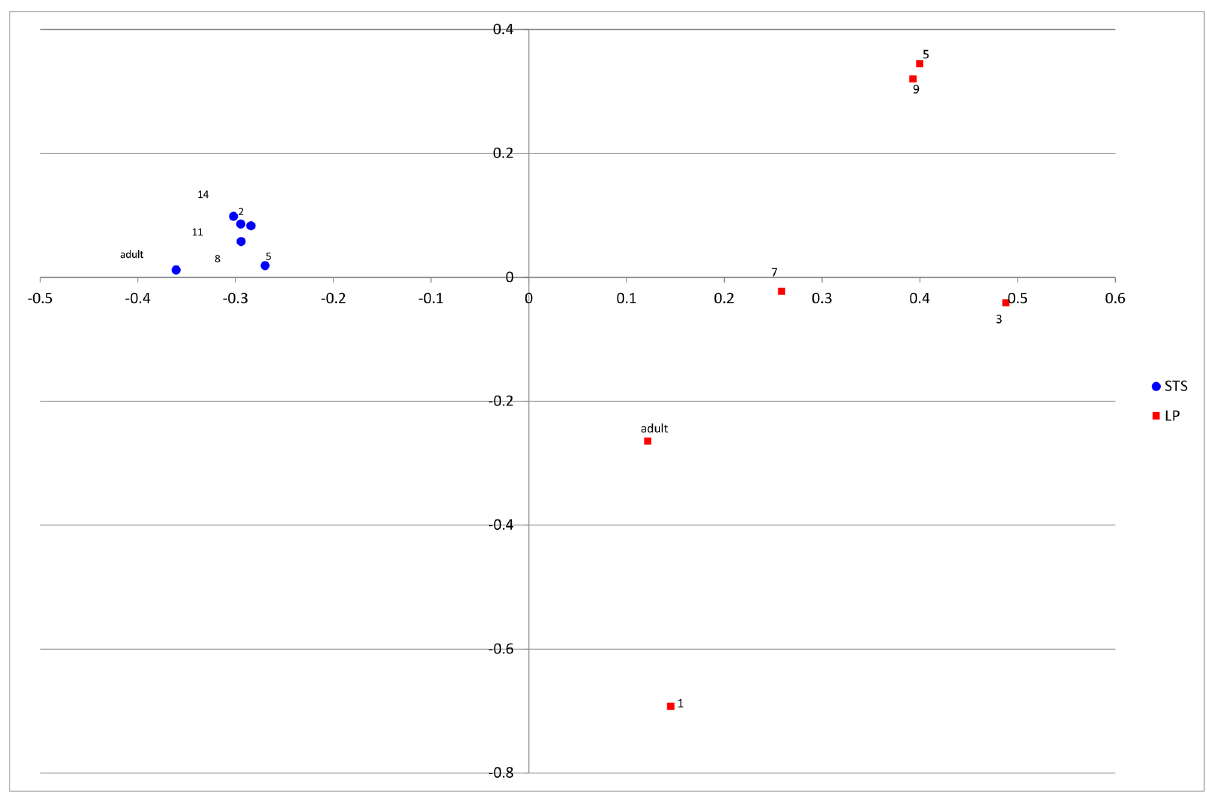
Fig 3. PCoA of weighted UniFrac distances among STS and LP samples. Points are labelledwith the chick age (weeks). LP = little penguin,STS = short tailed shearwater. PCO 1 and 2 shown, described49% and 23% of total variation respectively.